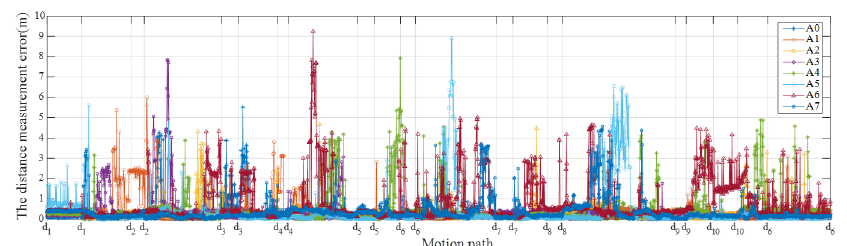
Figure 18. Range error of each anchor in Experiment